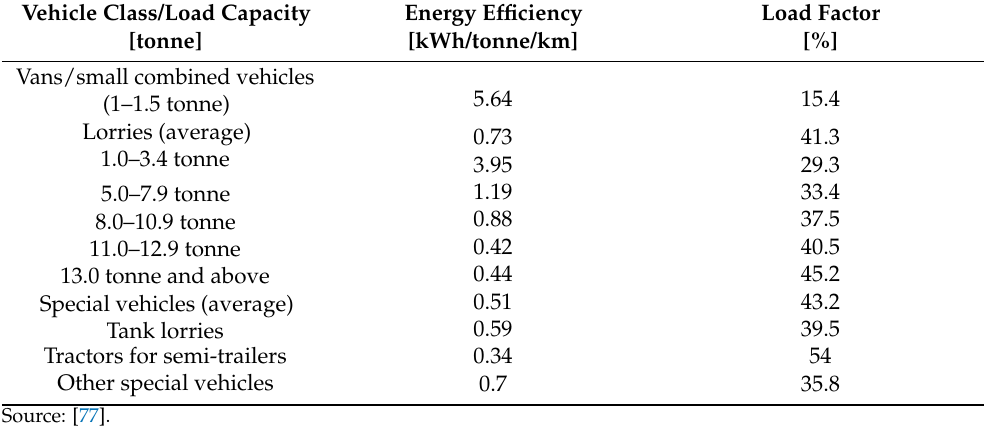
Table 2. Energy efficiency in Norwegian domestic goods transport on road, 1993–1995.